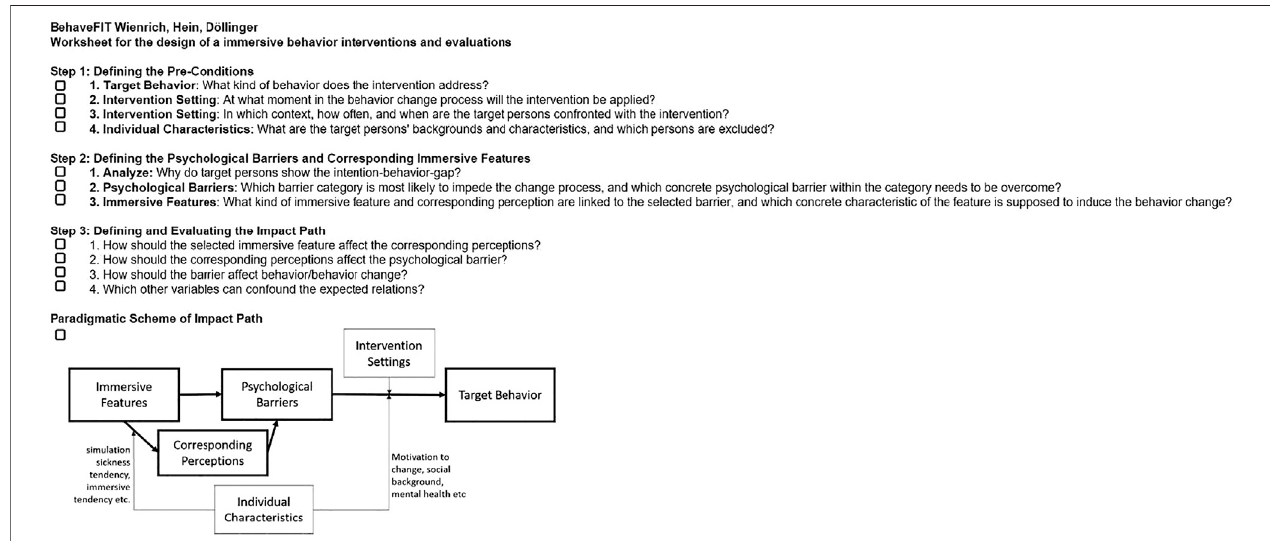
FIGURE 5 | The worksheet illustrates how BehaveFIT can be used for intervention and evaluation design.